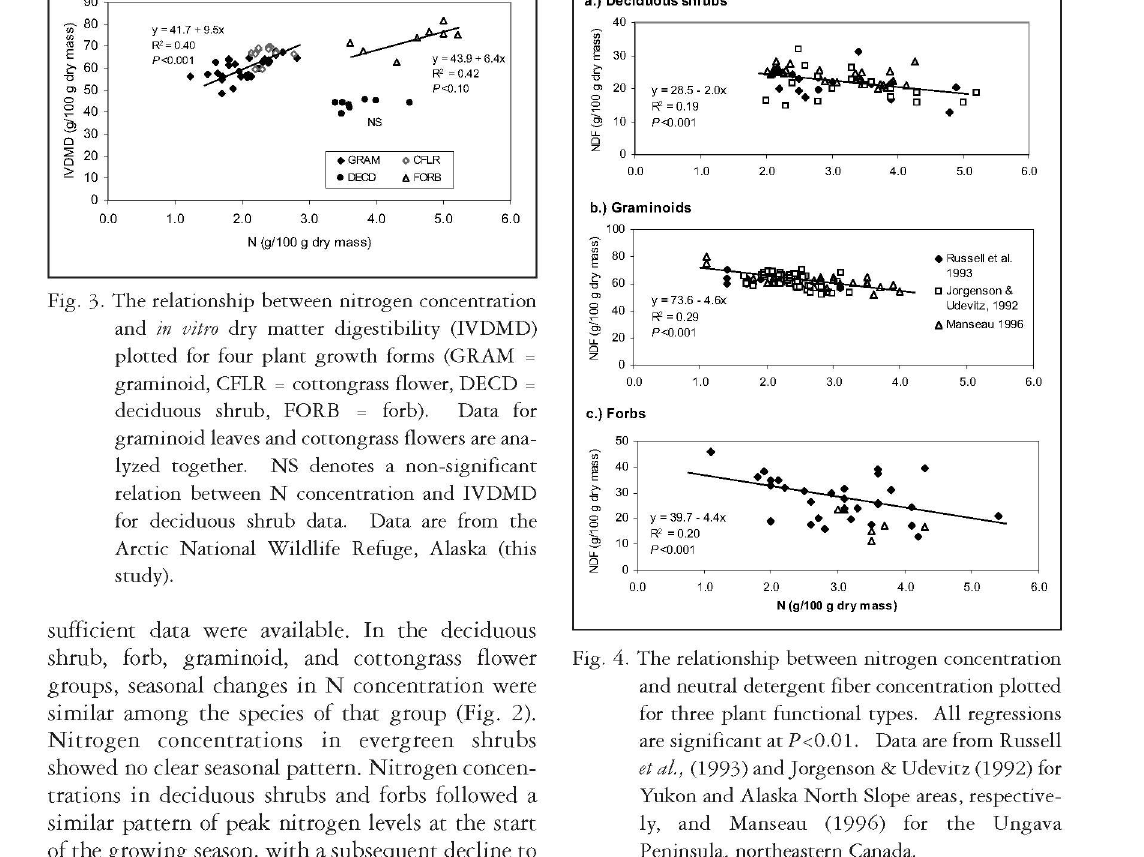
Fig. 4. The relationship between nitrogen concentration and neutral detergent fiber concentration plotted for three plant functional types. All regressions are significant at P <0.01. Data are from Russell et al., (1993) and Jorgenson & Udevitz (1992) for Yukon and Alaska North Slope areas, respective¬ ly, and Manseau (1996) for the Ungava Peninsula, northeastern